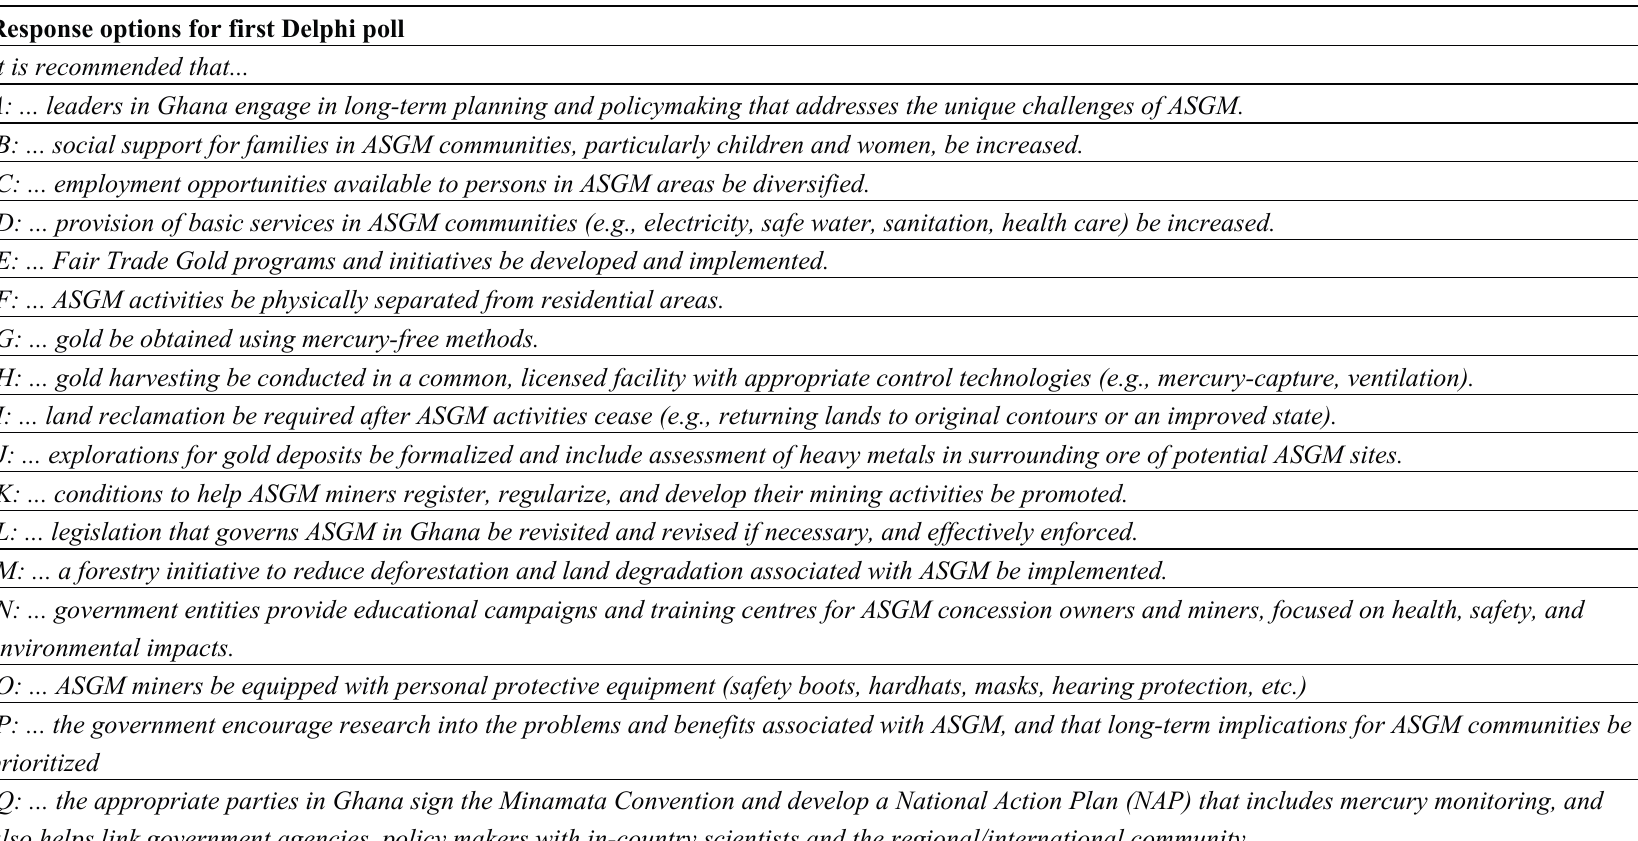
Table 1. Response options for the first and second Delphi